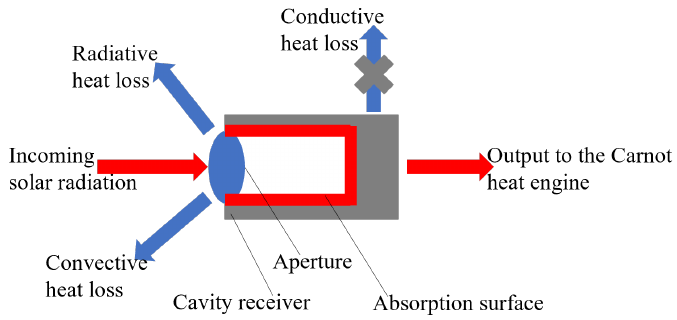
Figure 1. Schematic diagram of the energy flow in the cavity